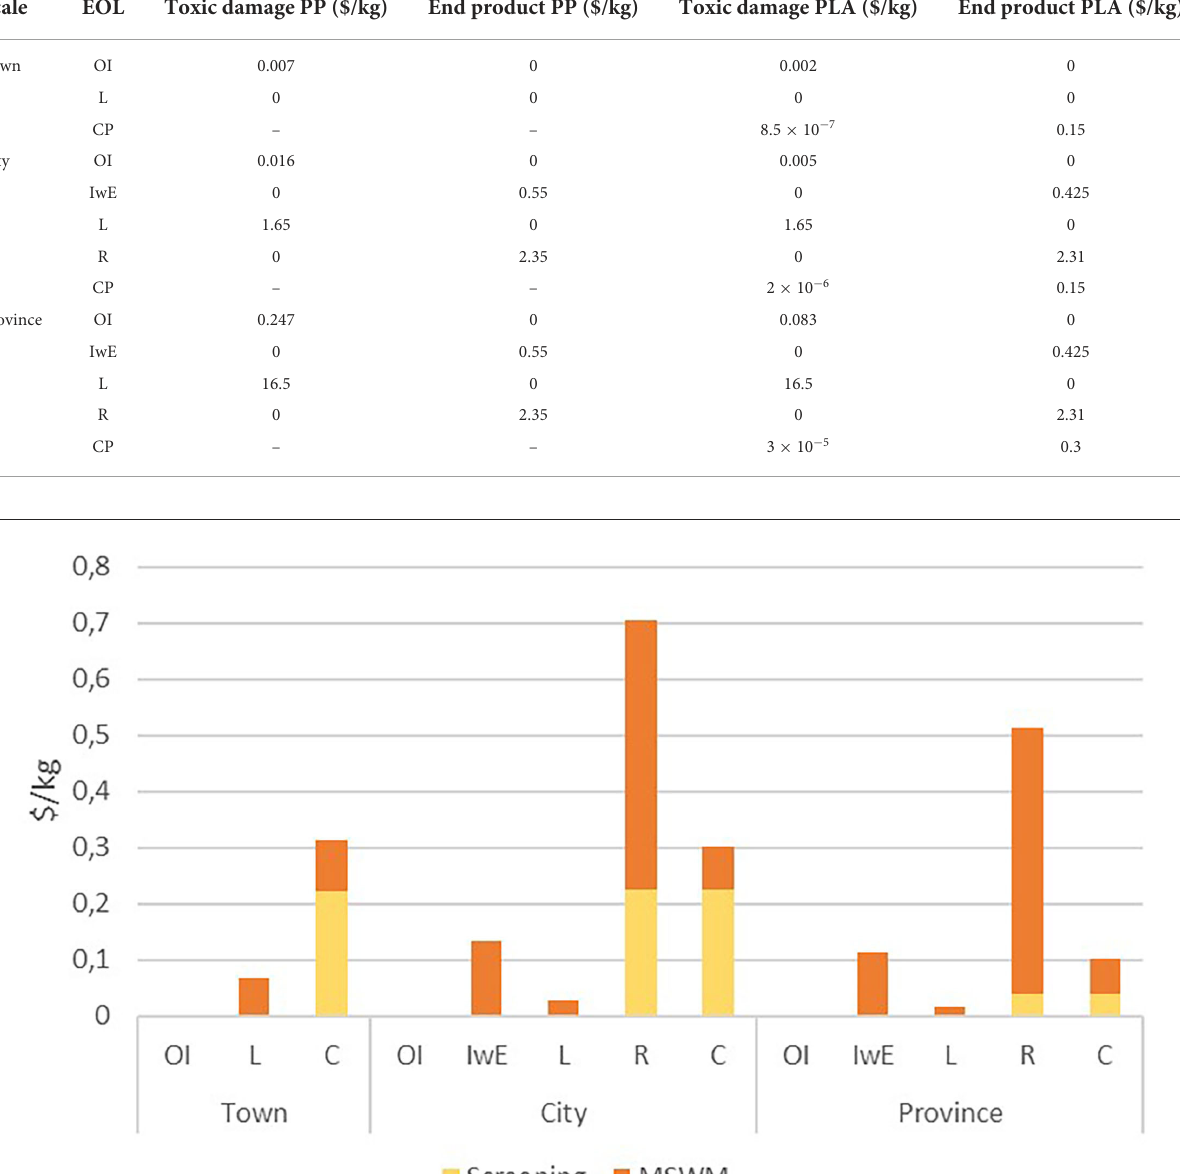
further for clear TEA results. The values in the model may be developed further by data from future